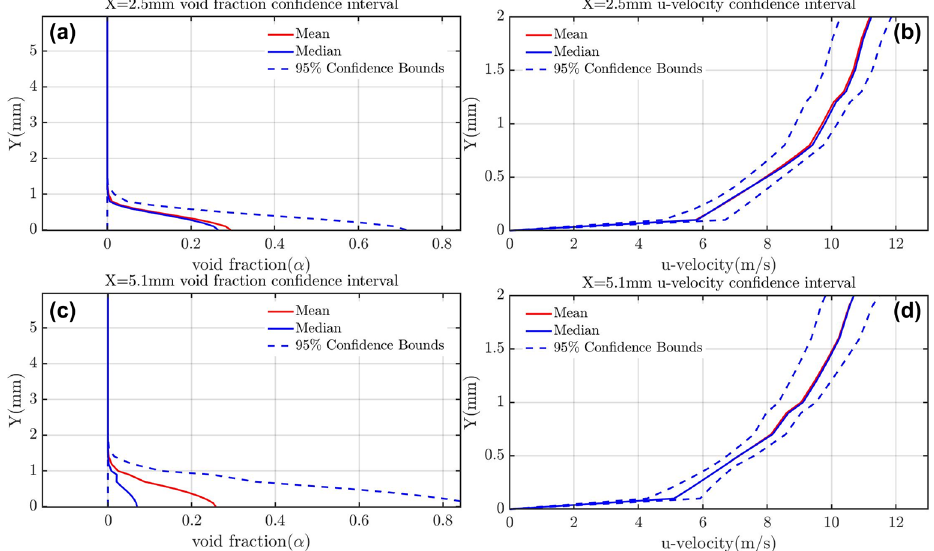
Figure 9. Confidence intervals of void fractions and u-velocity profiles at X = 2.5 mm and 5.1 mm. ( a ) void fraction at X = 2.5 mm, ( b ) u-velocity at X = 2.5 mm, ( c ) void fraction at X = 5.1 mm, ( d ) u-velocity at X = 5.1 mm.